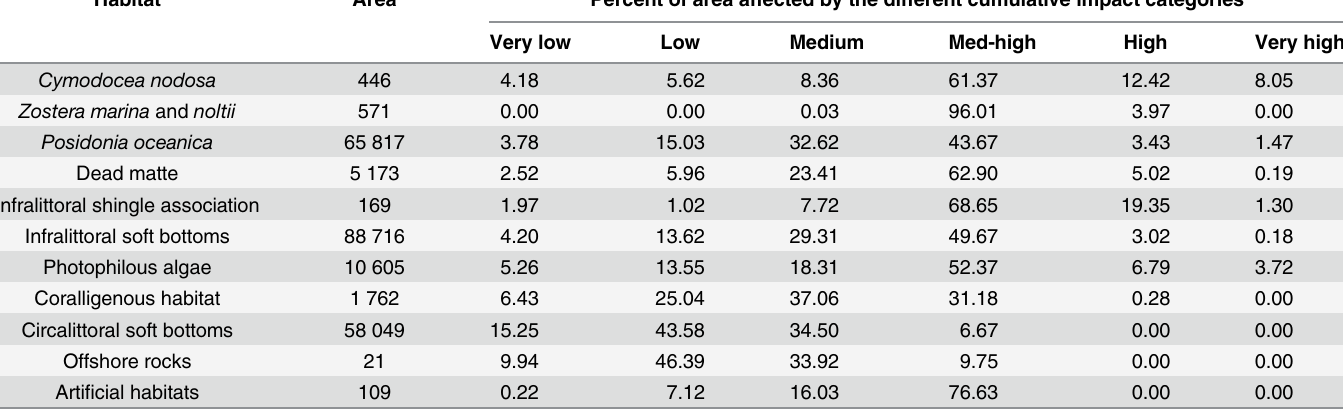
Table 2. Analysis of the cumulative impact categories per marine habitat. Percent of each marine habitat area affected by the different cumulative impact categories: very high impact (Ic > 10); high impact (8 – 10); medium-high impact (2.1 – 8); medium impact (0.6 – 2.1); low impact (0.1 – 0.6); and very low impact ( < 0.1). Areas are indicated in